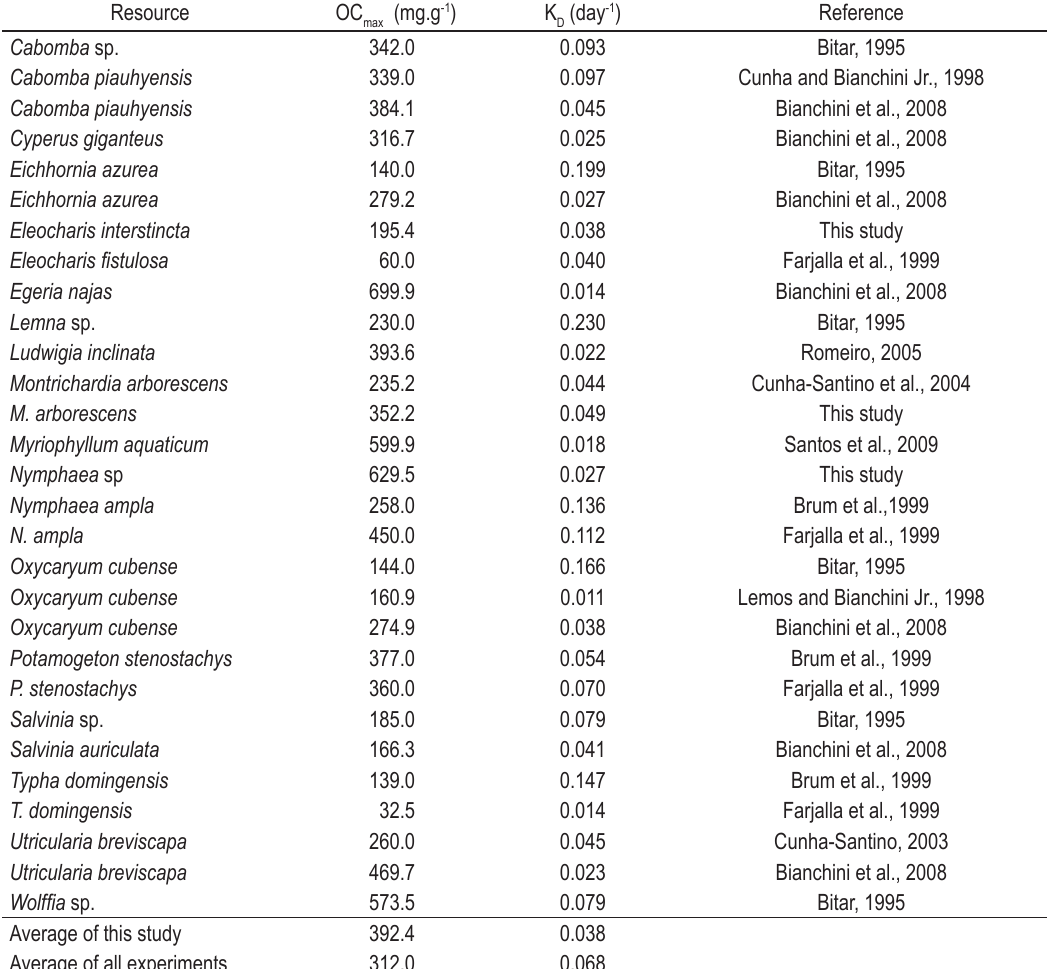
Table 2. Parameters derived from oxygen uptake model during aerobic decomposition of aquatic macrophytes. Where: OC = total amount of consumed oxygen and k max